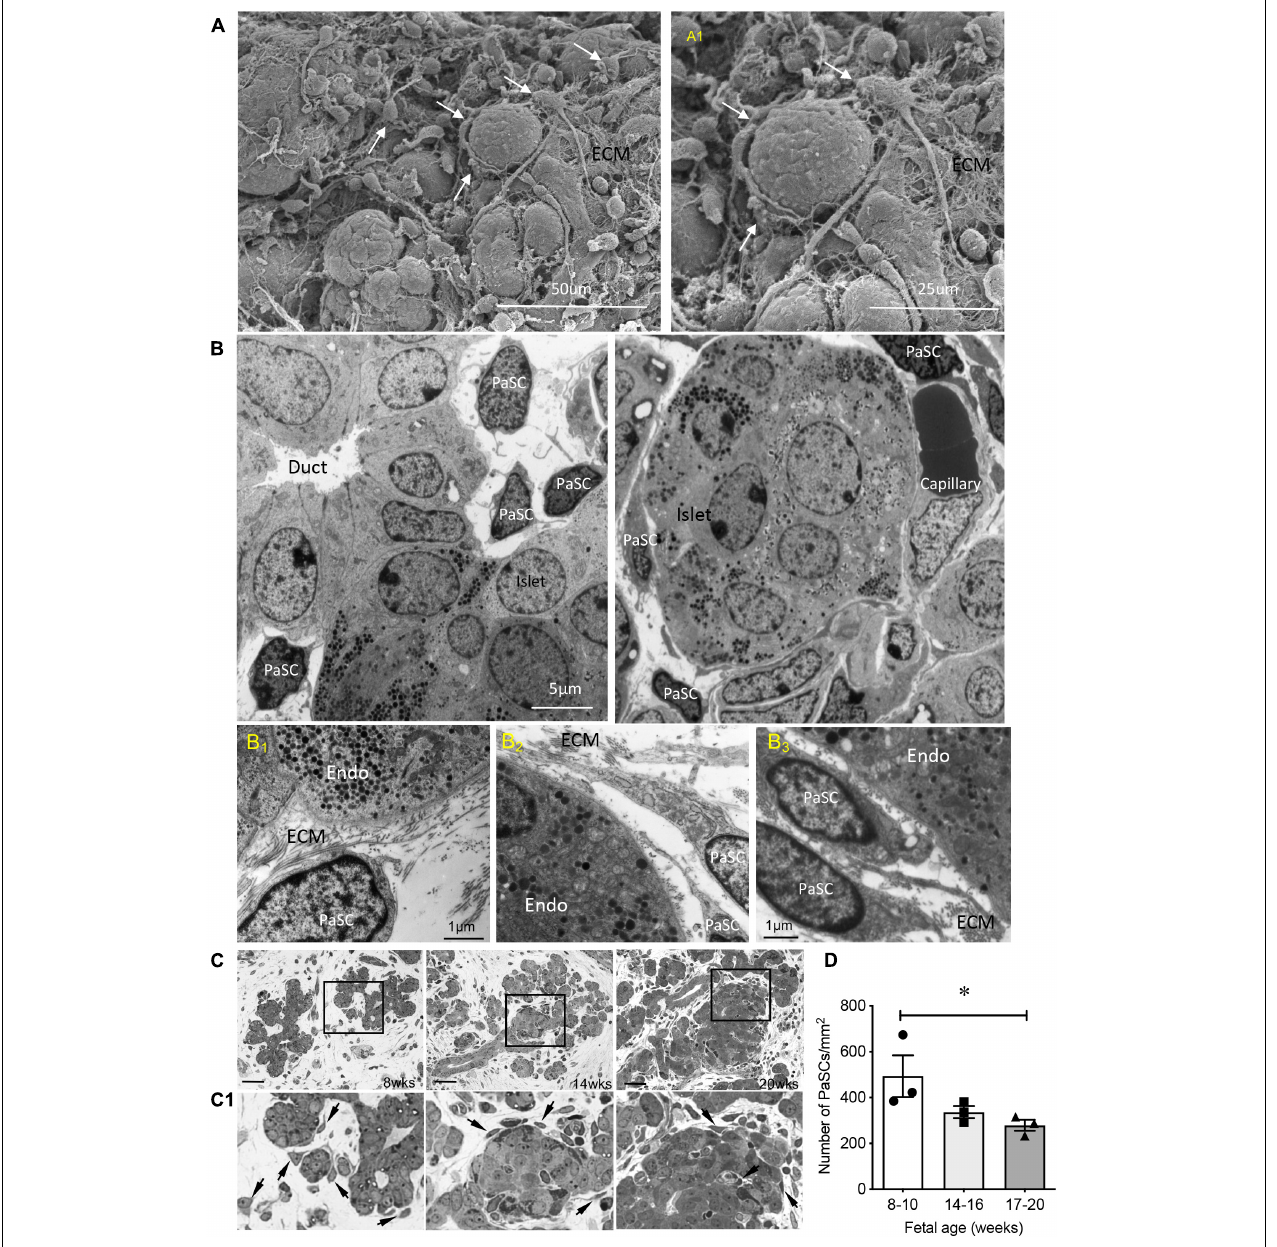
FIGURE 1 | Ultrastructure and distribution of PaSCs in the developing human fetal pancreas. (A) Scanning electron micrographs of a human fetal pancreas at 20 weeks fetal age. PaSCs are identified by the presence of long foot process structures (arrows) surrounding cell clusters. Highlighted area is enlarged in (A 1 ) . Scale bars = 50 µ m (A) and 25 µ m (A 1 ) . (B) Transmission electron micrograph of PaSCs displayed long foot processes and are located near ducts with new endocrine cells budding off (14 weeks, left) and an islet surrounded by capillaries (20 weeks, right) in the human fetal pancreas. Representative images from 4 to 8 pancreata (14 and 20 weeks of fetal age) are shown. (B 1 − 3 ) Highlighted transmission electron micrographs showed PaSCs and ECM fiber inter-connected to endocrine cells. Endo = endocrine cells, ECM = extracellular matrix. Scale bars = 5 µ m (B) and 1 µ m (B 1 − 3 ) . (C) Representative images of PaSCs distribution on semi-thin (500 nm) sections from 8, 14, and 20 weeks pancreases, and (D) quantification of the number of PaSCs present in the developing pancreas. Scale bar: 100 µ m. Magnified images are shown in (C 1 ) , arrows indicate PaSCs. Closed circles, 8–10 weeks; closed squares, 14–16 weeks; closed triangles, 17–20 weeks. Data are expressed as mean ± SEM ( n = 3 pancreata/age group). ∗ p < 0.05, analyzed using one-way ANOVA with Tukey’s post hoc test.